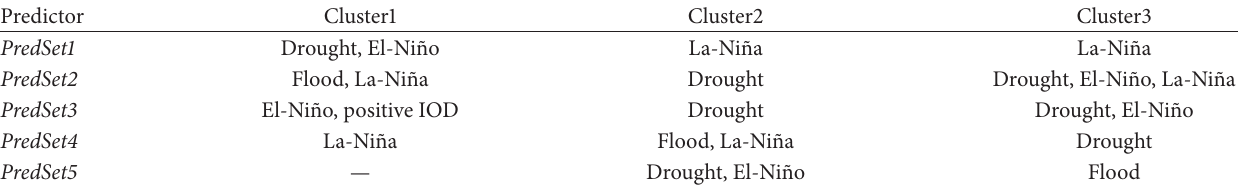
Table 13: Identified physical climatic events being associated with clusters obtained by fuzzy clustering.